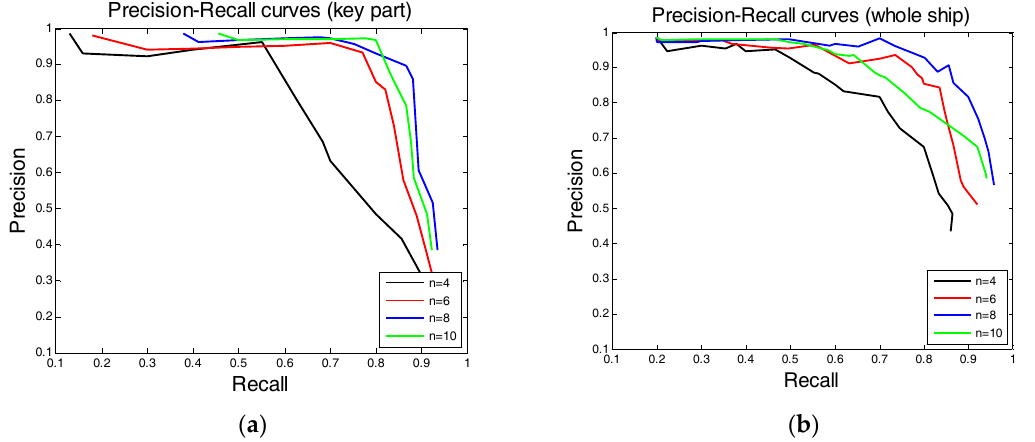
Figure 6. Precision-recall curves as parameter n varies: ( a ) key part sub-model detection results when n = 4,6,8,10 and ( b ) whole ship sub-model detection results when n = 4,6,8,10.